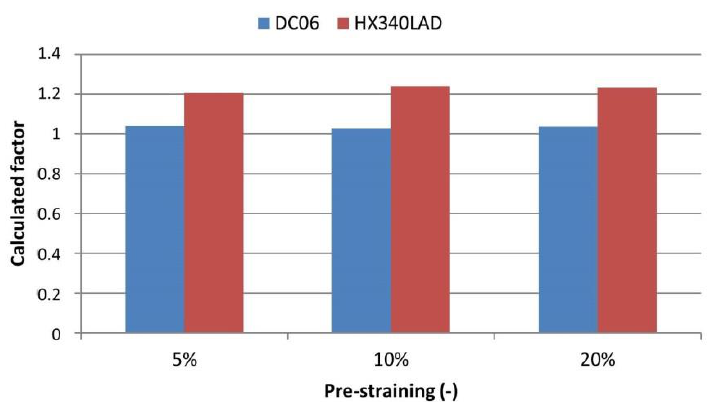
Figure 8. Derived calculated factors for both materials by three different pre-straining.